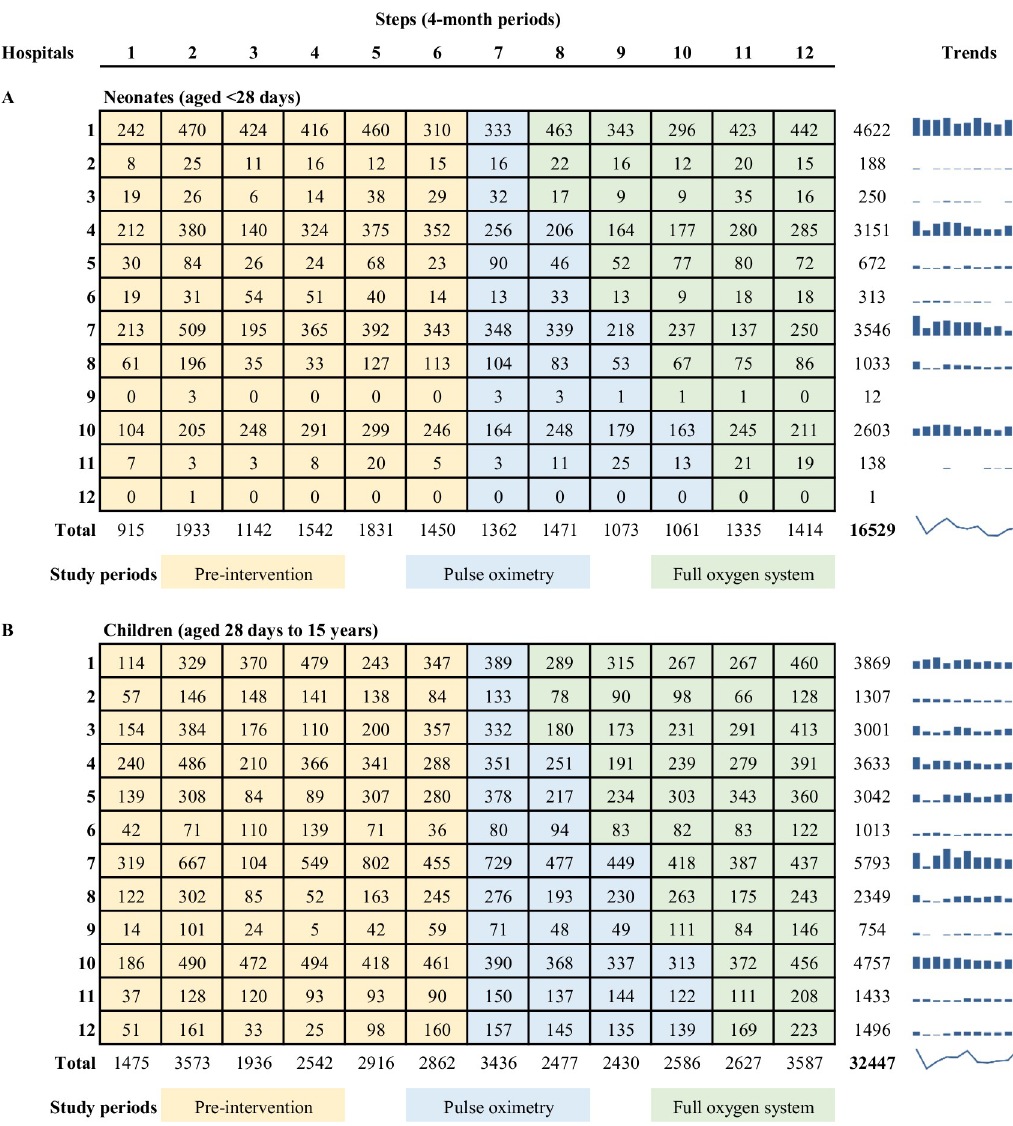
Fig 1. Study diagram showing number of admissions in each hospital, by step. Rows indicate individual hospitals (clusters). Columns indicate individual time periods (steps). Numbers indicate the number of neonatal (A) and child (B) participants included in analyses (excluding those admitted during the 2-week transition period at the beginning of each step). We provided all hospitals with pulse oximeters and training in November 2015 (step 7) and then introduced a multifaceted improved oxygen system to three hospitals every 4 months (randomised order). Blue bar graphs show the hospital-specific admission trends over time for quick reference, with the overall trend for neonates and children indicated with a spark-line. Notes: Data from November/December 2013 not available (first half of step